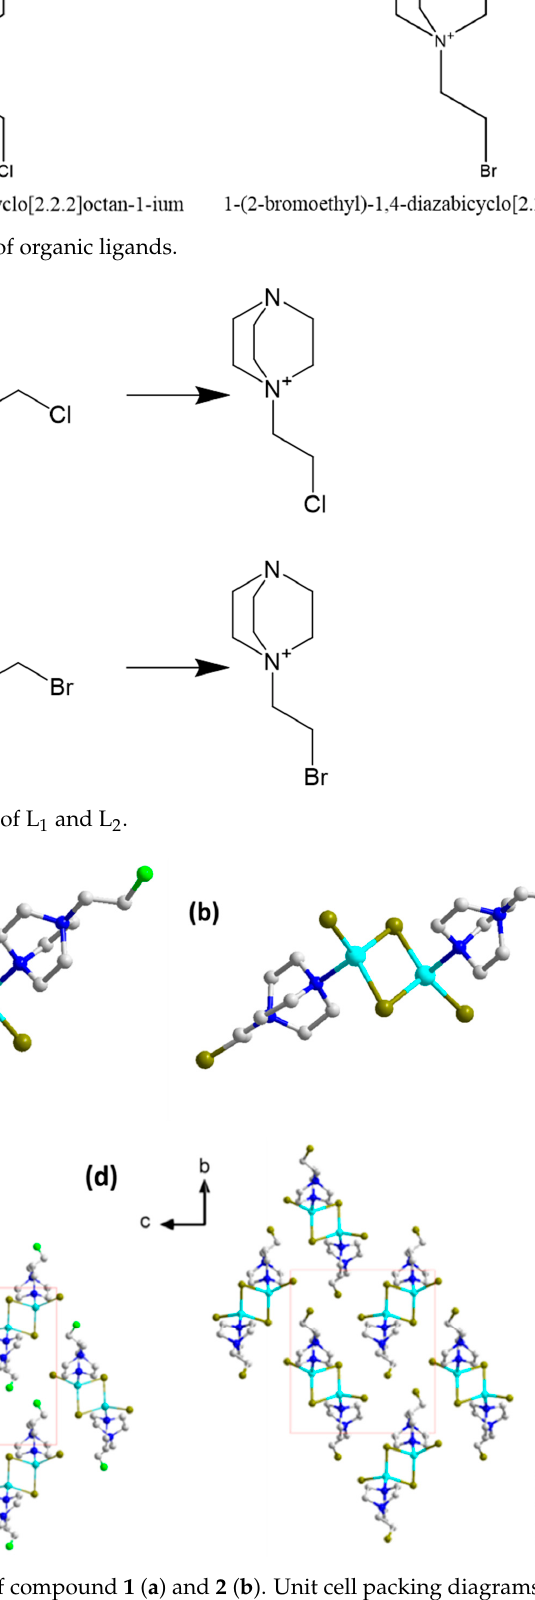
Figure 3. Structural plot of compound 1 ( a ) and 2 ( b ). Unit cell packing diagrams of 1 ( c ) and 2 ( d ).